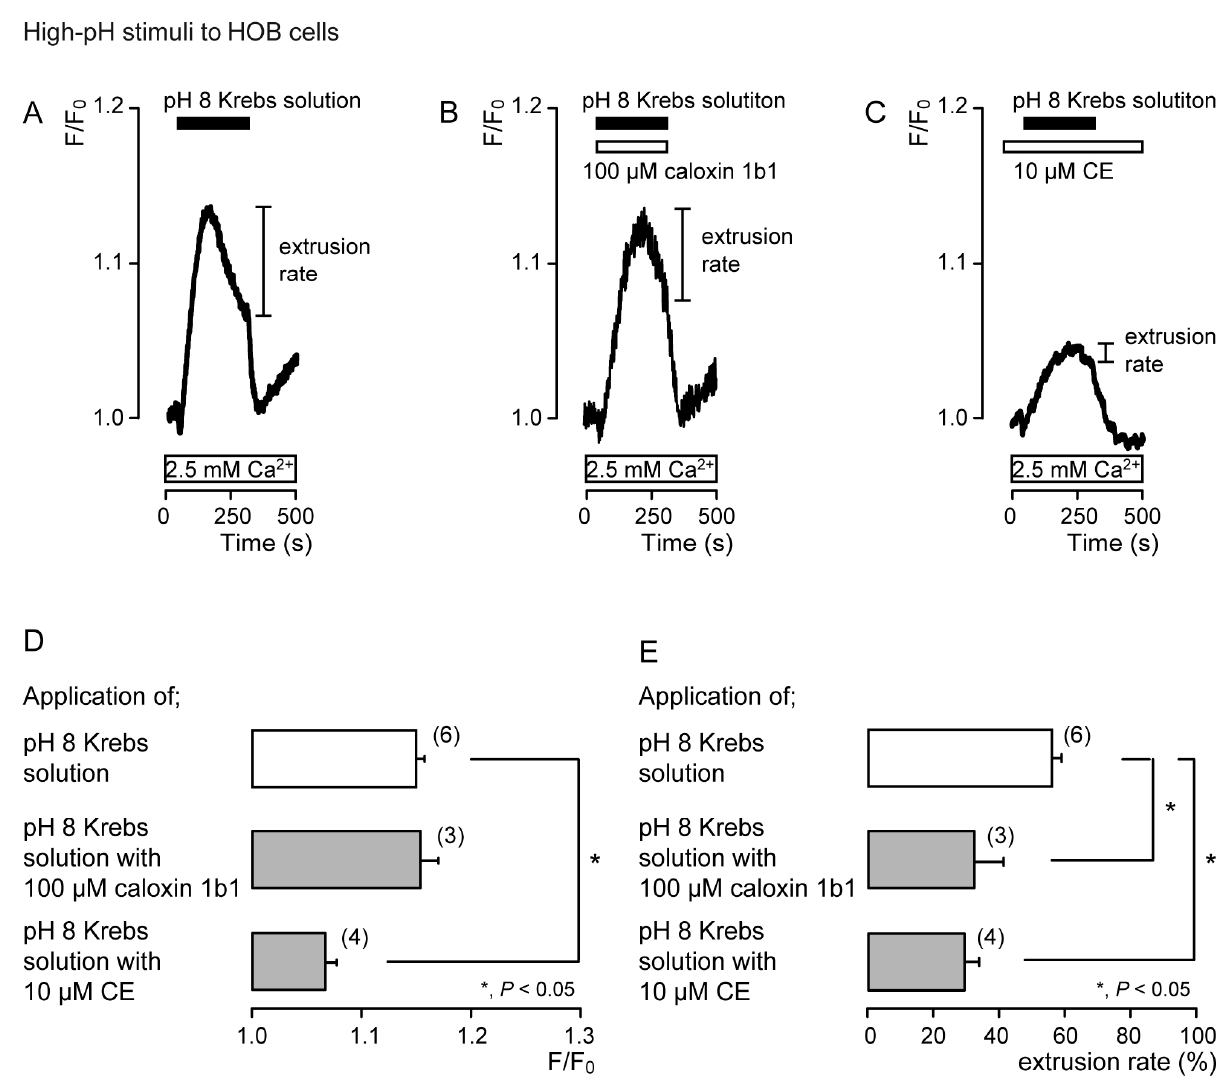
Figure 5. PMCA mediates Ca 2+ extrusion following high-pH stimuli in HOB cells. ( A – C ) Representative traces for pH 8 (black boxes)-induced [Ca 2+ ] i increases, in the absence of 100 µ M caloxin 1b1 and 10 µ M CE ( A ), with 100 µ M caloxin 1b1 (white box at the top) ( B ), or with 10 µ M CE (white box at the top) ( C ), in the presence of extracellular Ca 2+ (white boxes at bottom in A to C). ( D ) Peak values of [Ca 2+ ] i during high-pH stimulation in the absence of 100 µ M caloxin 1b1 and 10 µ M CE (open column; 1.15 ± 0.01 F/F 0 units), with 100 µ M caloxin 1b1 (upper gray column; 1.15 ± 0.02 F/F 0 units), and with 10 µ M CE (lower gray column; 1.07 ± 0.01 F/F 0 units). Each column denotes the mean ± SE from 6, 3, and 4 independent experiments, respectively. ( E ) Ca 2+ extrusion rates during high-pH stimulation in the absence of 100 µ M caloxin 1b1 and 10 µ M CE (open column; 55.6 ± 3.0%), with 100 µ M caloxin 1b1 (upper gray column; 32.4 ± 8.5%), and with 10 µ M CE (lower gray column; 29.0 ± 4.4%). Each column denotes the mean ± SE from 6, 3, and 4 independent experiments, respectively. Statistically significant differences (in ( D , E )) between columns (shown by solid lines) are indicated by asterisks. * P < 0.05.